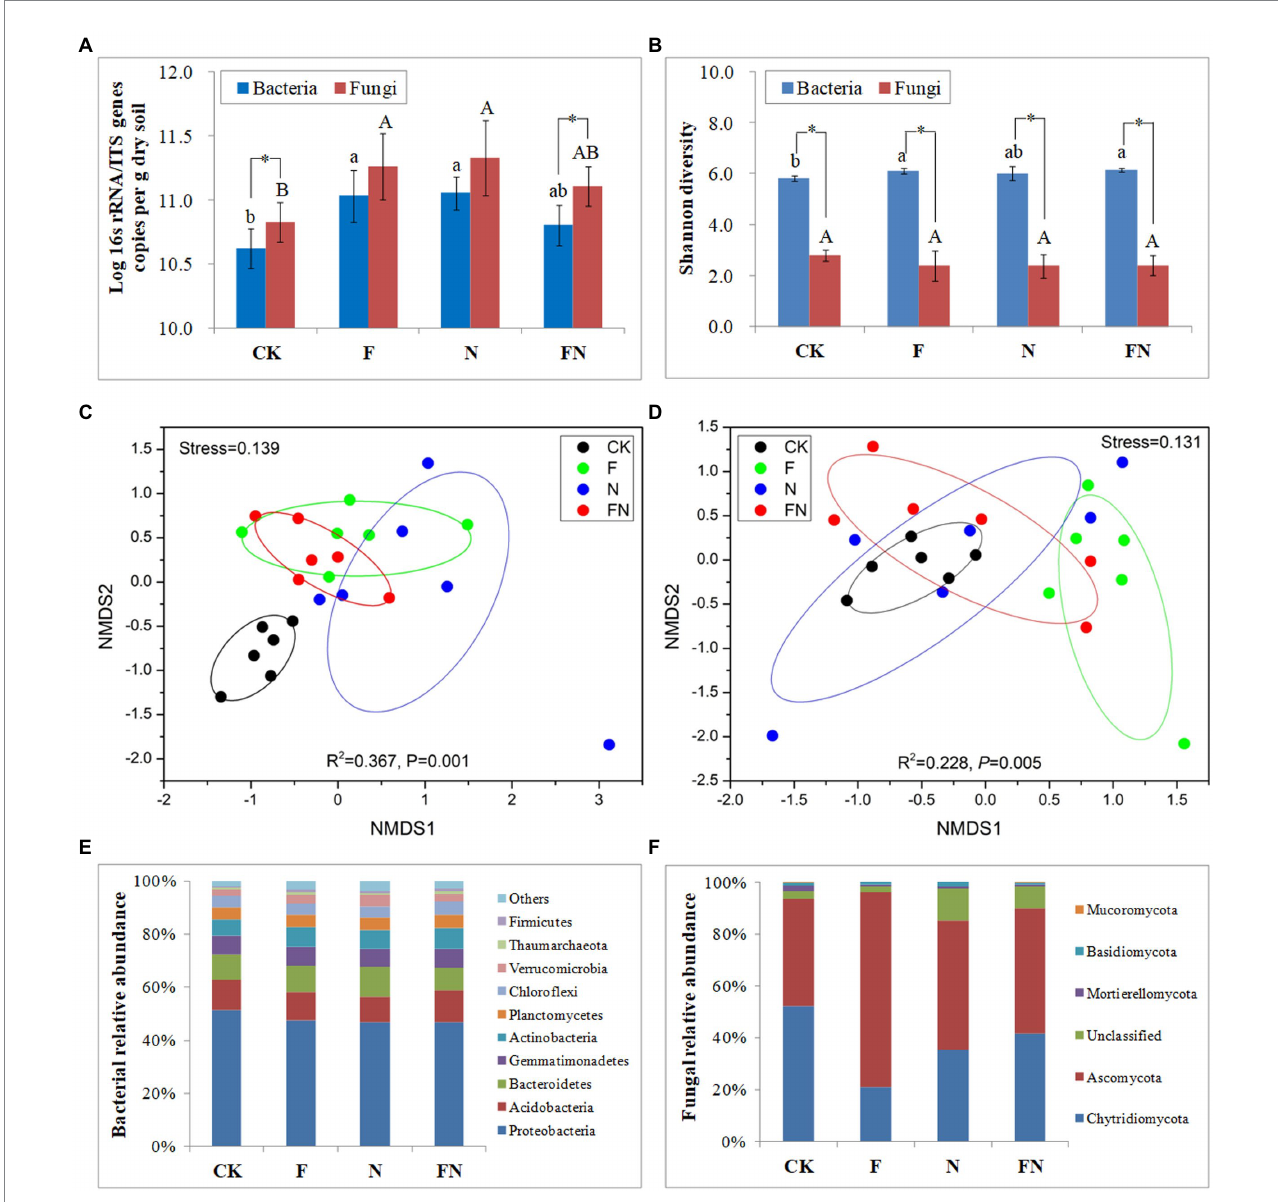
FIGURE 2 The effects of different microbial inoculants on rhizosphere microbiome. (A) Microbial quantity; (B) microbial α diversity; (C) bacterial β diversity; (D) fungal β diversity; (E) bacterial composition; (F) fungal composition. Beta diversity was revealed by NMDS using bray curtis. CK, non-inoculated; F, inoculated with B. velezensis FH-1; N, inoculated with B. diminuta NYM-3; FN, inoculated with B. velezensis FH-1 and B. diminuta NYM-3. Data followed by the different letters are significantly different at p ≤ 0.05. Significance levels are indicated by *( p < 0.05), **( p < 0.01) and ***( p <